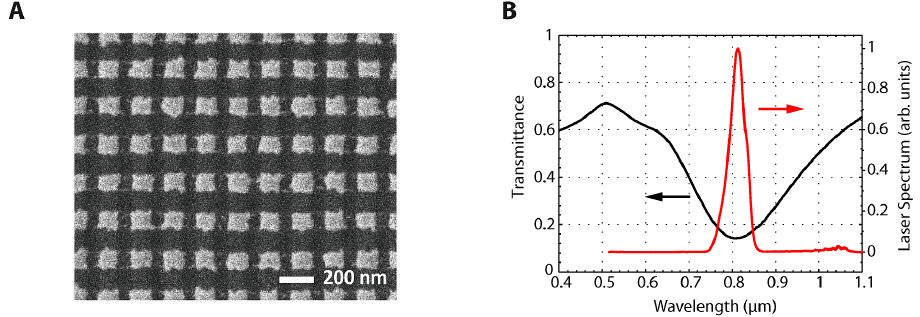
Figure 9: Characteristics of the tested sample of resonant, field-enhancing nano-rectangles. a , The sample is produced by Electron-beam Lithography out of a 20nm thick gold layer. The sides of a single rectangle are both approximately 100nm long, positioned at a 200nm periodicity (SEM image courtesy of D. Cialla-May). b , The dip in transmittance of light polarized parallel to the slightly longer axis reveals a resonance that matches perfectly with our employed laser spectrum. The resonance of the shorter axis lies nearby, around 710nm (Optical characterization courtesy of J.